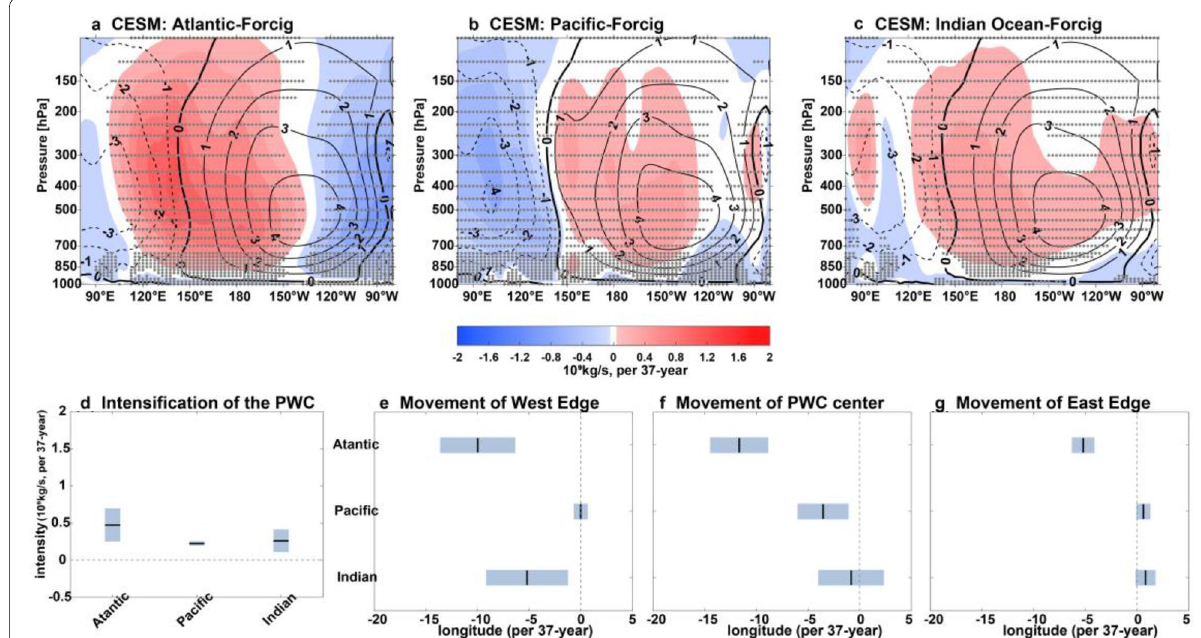
Fig. 6 The simulated trends of the PWC in the pacemaker experiments with the earth system model. a Shows the simulated climatology (contours) and the trend (color shading) of the mass stream function of PWC in the Atlantic‑forcing pacemaker experiments, with b , c showing the simulated PWC trends in the Pacific‑, and the Indian Ocean‑forcing experiments. The gray dots cover the areas with confidence level of 95%. d Quantifies the trends of the PWC in each of the three pacemaker experiments, with black bars showing the amplitude of the trend and the error bars indicating its 95% confidence intervals. e – g Quantify the westward shifts of the west edge ( c ), the center of ( d ), and the east edge ( e ) of the PWC in these